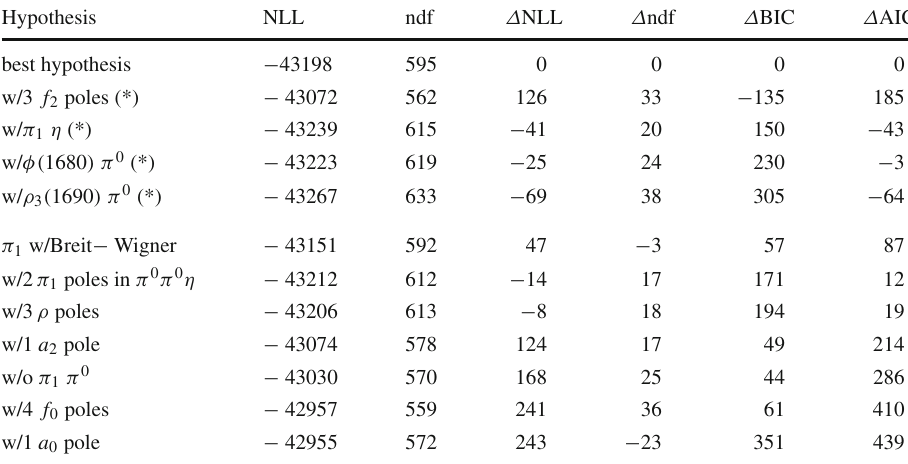
Table 2 Likelihood values and the number of free parameters for fits with the best and alternative hypotheses. Δ NLL, Δ ndf, Δ BIC and Δ AIC are the differences of the obtained negative log likelihood values, the number of free parameters as well as the BIC and AIC values between the alternative and the best hypothesis. The fits marked with (*) are taken into account for the estimation of the systematic uncertainties. Exemplarily, the results using the scattering data for the solution ( − − − ) from [21]